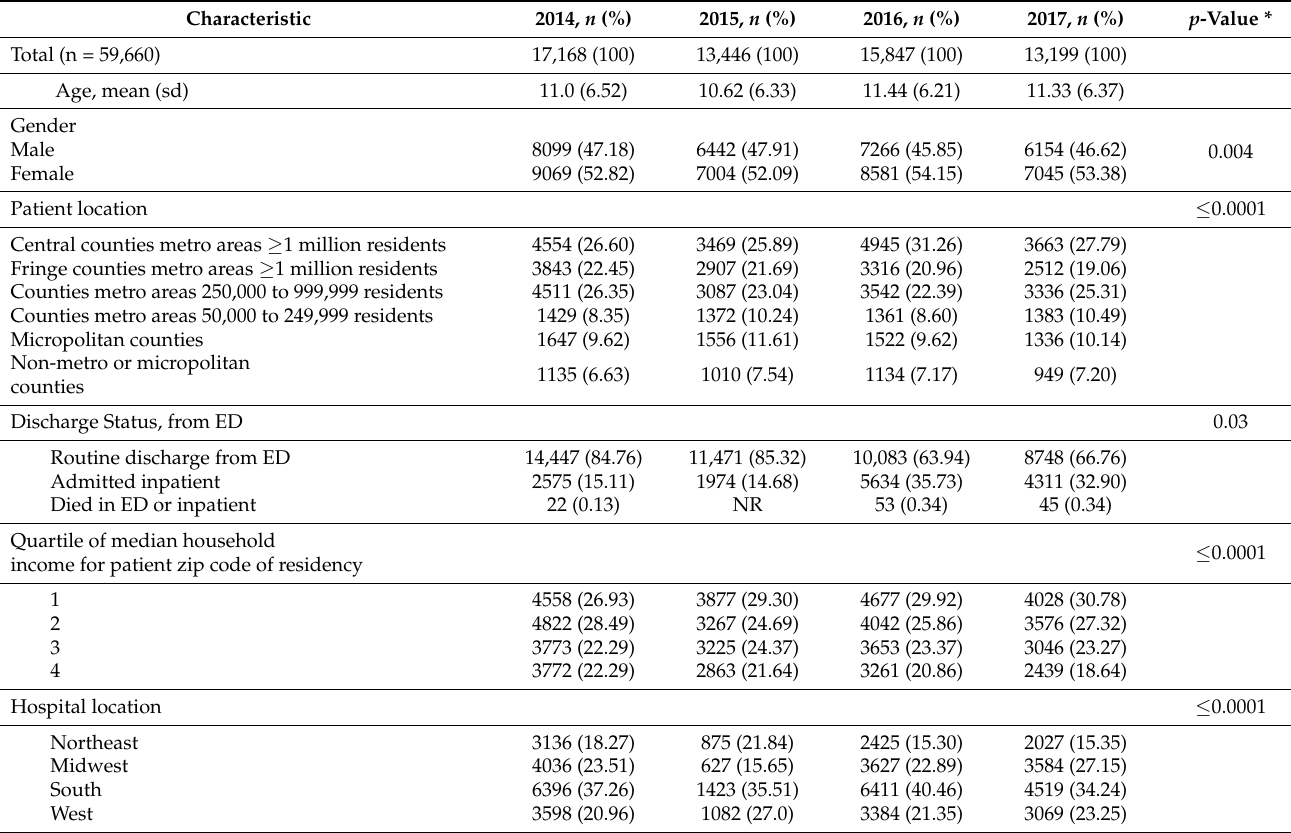
Table 2. Univariate analysis of patient characteristics of weighted children visits with any relevant opioid diagnoses, 2014–2017.